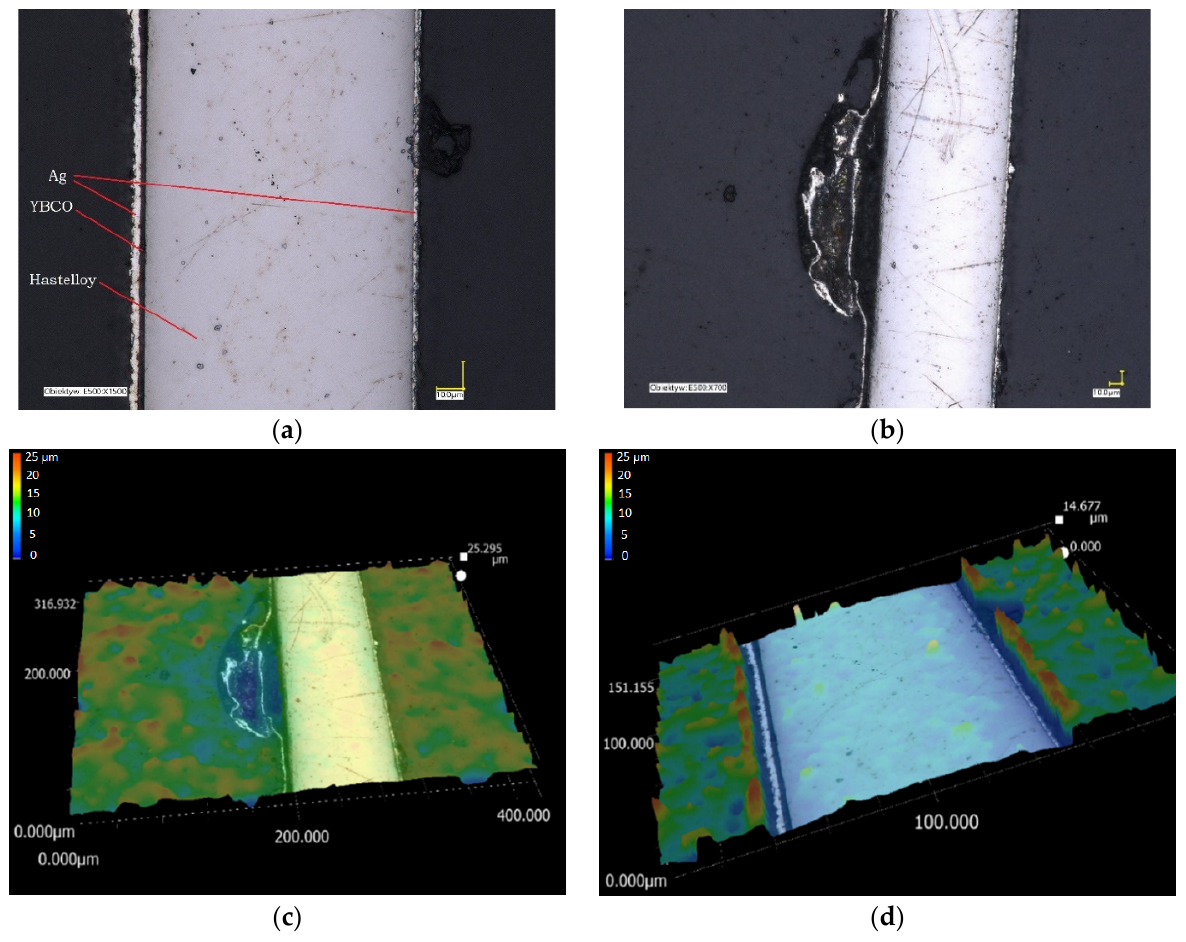
Figure 21. The images show cross-sections of tape samples obtained with an optical microscope: ( a ) control sample (Lens: E500: ×1500) and ( b ) sample subjected to surge currents (Lens: E500: ×700). The corresponding topographic maps are presented below ( c , d ).